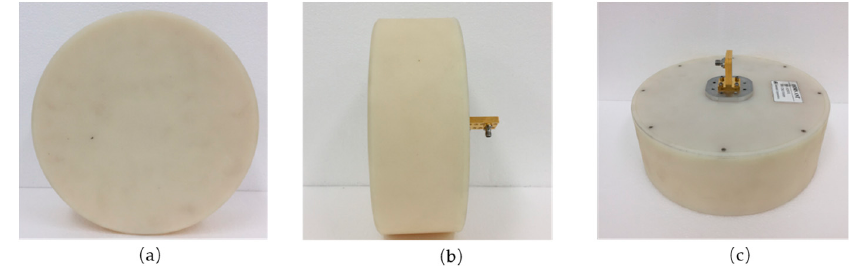
Figure 4. Illustration of Tx lens antenna, ( a ) front view; ( b ) side view; ( c ) back view.